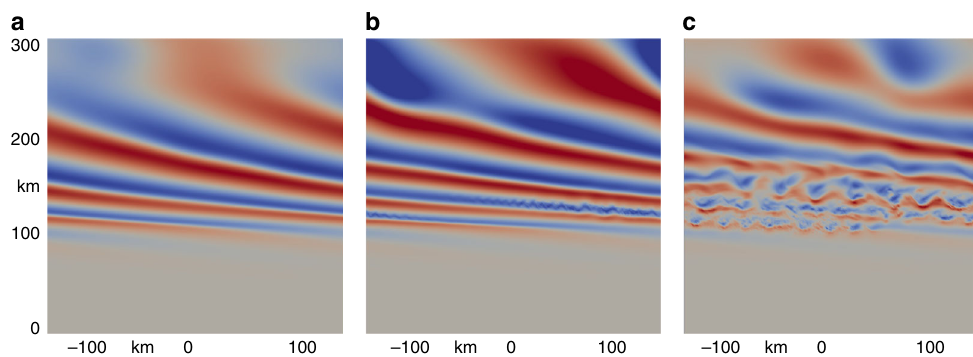
Fig. 8 Cross-sections of GW and KHI u ′ . At a 138, b 155, and c 172 min after initiation of the GW packet at lower altitudes. Maximum u ′ is